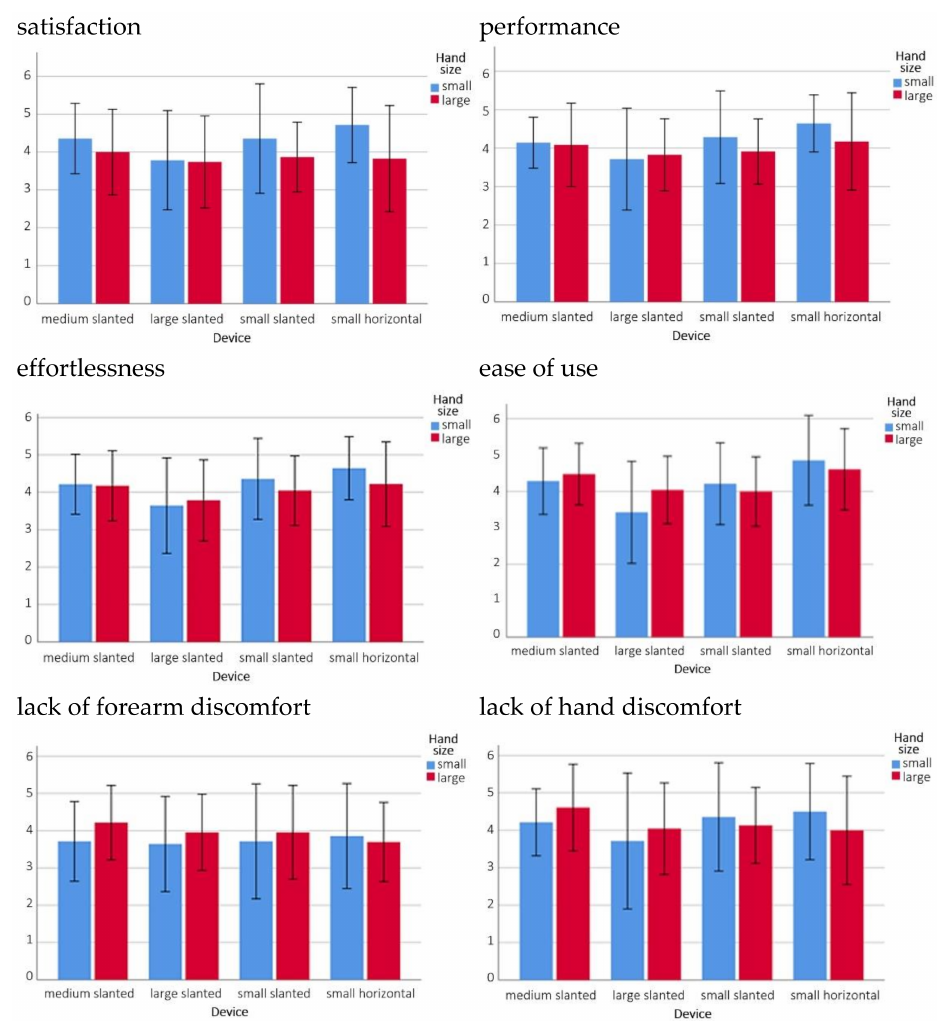
Figure 2. Clustered bar charts of the mean and standard deviation of subjectively rated satisfaction, ef- ficiency, effort, ease of use, forearm discomfort, and hand discomfort by hand size and device [Higher values are more positive than lower values, e.g., satisfaction: 6–Very satisfied; 0–Not satisfied]. Correlation analysis among the dimensions subjectively rated suggests very high consistency between subjective self-assessed performance and satisfaction, as well as effortlessness. The lowest level of association is found between lack of forearm discomfort and ease of use, followed by lack of forearm discomfort and satisfaction, albeit with about 50% of co-variance among both pairs. Co-variance for the remaining pairs is in the range of 60 to 70%. These subjective experimental results indicate more co-variance of lack of hand discomfort than lack of forearm discomfort with ease of use, performance, and satisfaction. Conversely, lack of forearm discomfort shows slightly more co-variance with effortlessness than does lack of hand